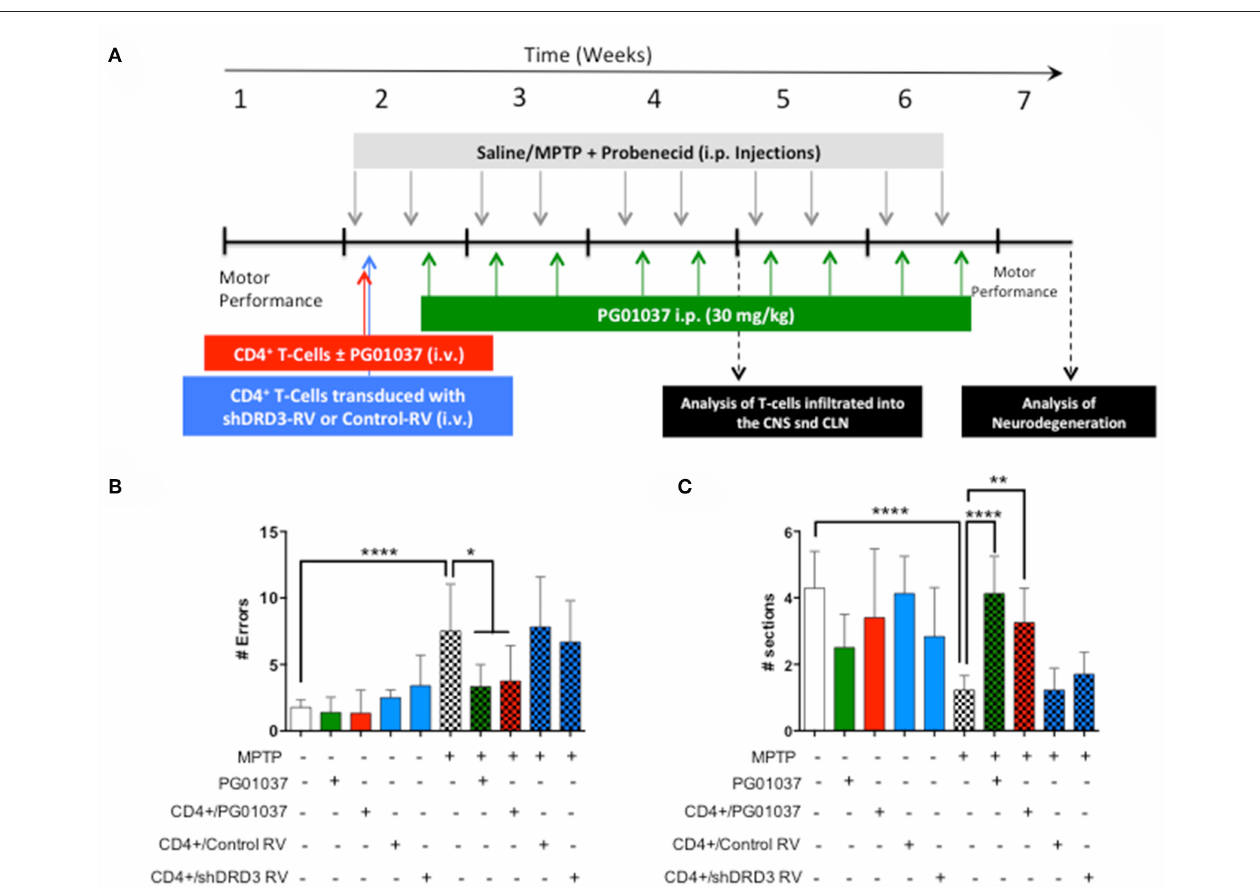
FIGURE 5 | Comparison of the therapeutic potential of the systemic DRD3-antagonistm or the intravenous transference of CD4 + T-cells transduced with shRNA for DRD3 or treated with a DRD3 antagonist on the motor performance of MPTPp-treated mice. (A) Experimental design: Control animals (without MPTPp treatment) were treated with saline and probenecid alone, or with i.p. PG01037, or the i.v. transference of CD4 + T-cells treated with PG01037, transduced with RV-Control or transduced with RV-shDRD3. MPTPp animals received 10 i.p. injections with MPTP (20 mg/kg) and probenecid (250 mg/kg) during weeks 2–6 (grey arrows). CD4 + T-cells (4 × 10 5 cells per mouse) were treated with 20nM PG01037 (red) or transduced with retroviral particles (MOI 1:1) codifying for RV-Control or RV-shDRD3 (blue) and then i.v. injected in experimental animals 1 day after the first MPTPp injection. Mice treated with systemic DRD3-antagonism (green) received 9 i.p. injections of PG01037 (30 mg/kg) administered 1 day after MPTPp injections starting after the second MPTPp administration. T-cell infiltration was analysed after 3 weeks of MPTPp-treatment. Neurodegeneration was analysed 1 week after the last MPTPp injection. Motor performance was analysed the week before beginning with MPTPp administration to distribute experimental groups with homogeneous motor performance and then it was evaluated again 16h after the last MPTPp injection in the Beam-test (B) and in the coat-hanger test (C) . Data represents the mean with the SEM. One-way ANOVA followed by Tukey’s multiple comparison post hoc test were used to determine statistical differences: * p < 0.05, ** p < 0.01, **** p < 0.0001, n = 5–12 mice per